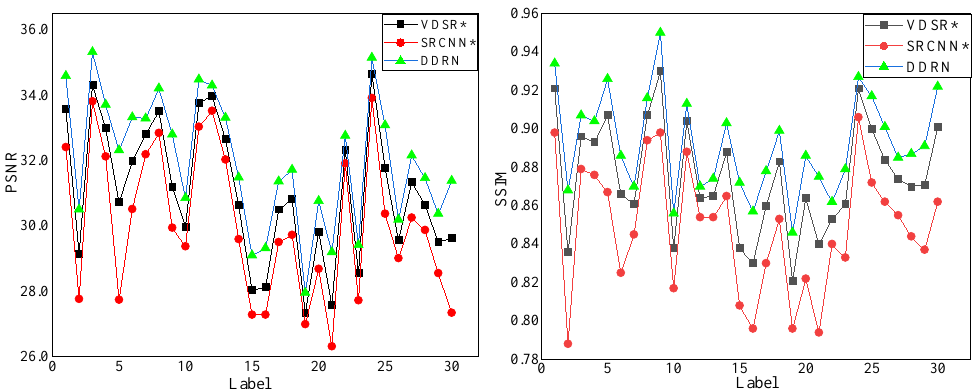
Figure 6. The SR performance comparisons for 30 different scenarios (denoted by label) from Kaggle Open Source Dataset . The competitive algorithms marked by * denote the retrained versions with our